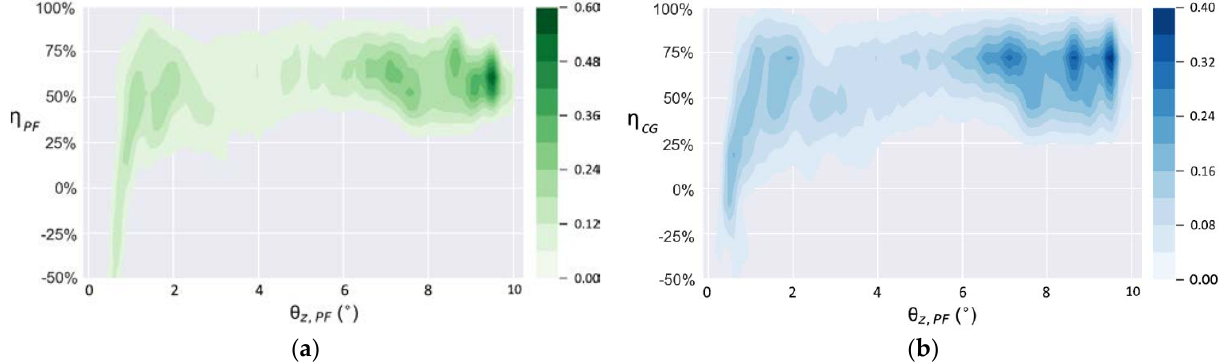
Figure 18. Density distribution of balance efficiencies when T = 20 s: ( a ) η